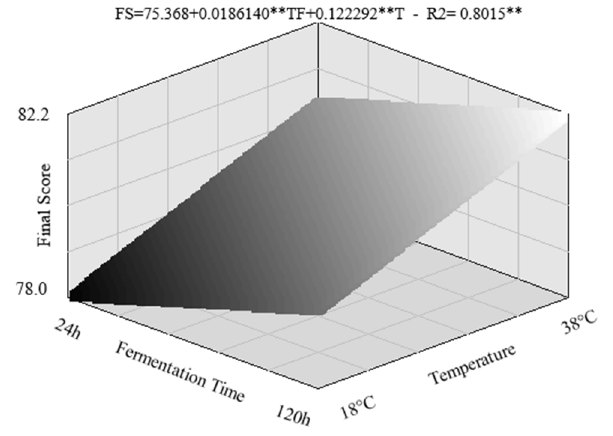
Figure 2. Response surface of the final score of the sensorial analysis of the coffees submitted to the tested fermentation times and periods. FS = Final Score, TF = Fermentation Time, T = Temperature. Regression models * and ** Significant at 5% and 1% probability levels by the T (Regression equation) and F (R2) tests, respectively.